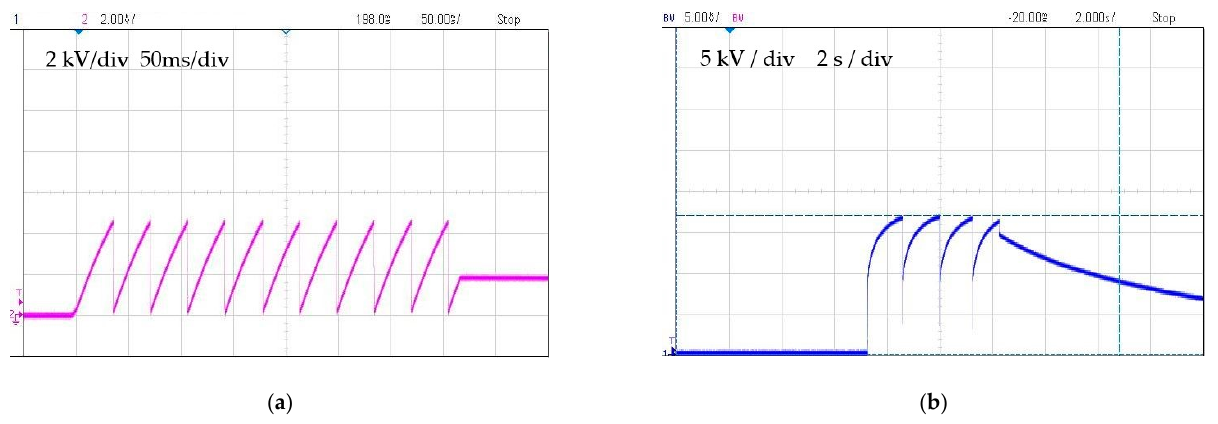
Figure 13. Output voltage measured when the spark gap is connected and firing at 5 kV ( a ) and 16.9 kV ( b ).